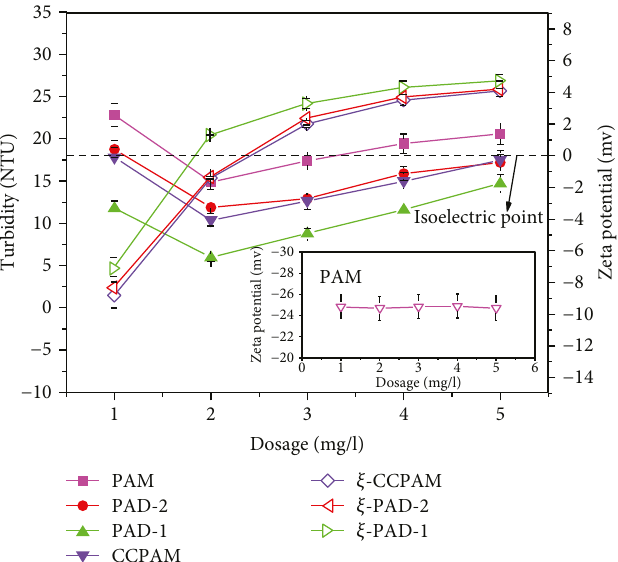
Figure 12: E ff ect of the dosage on turbidity and zeta potential.